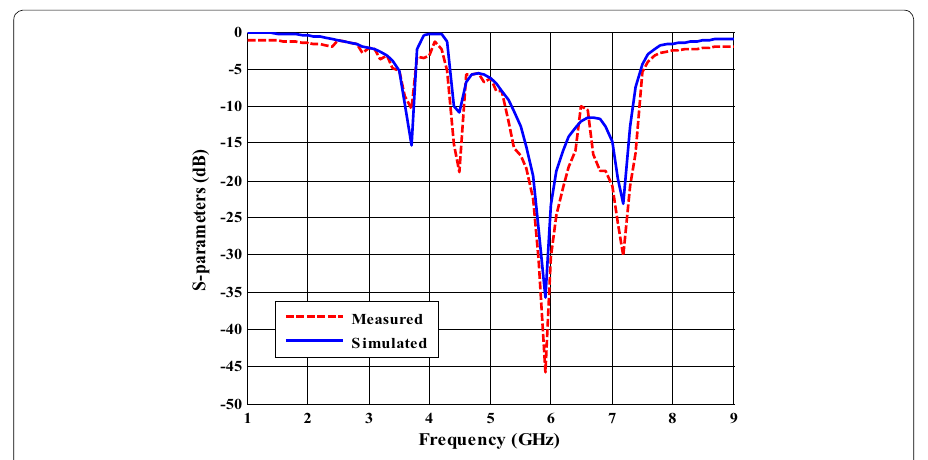
Fig. 11 Simulated and measured S 11 of DB-BPF